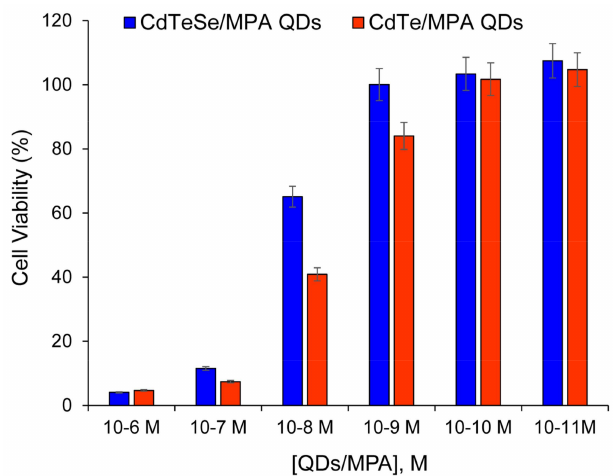
Figure 8. Viability of human cancer cells (HeLa) cells after exposure to the MPA-capped CdTe and CdTeSe QDs.